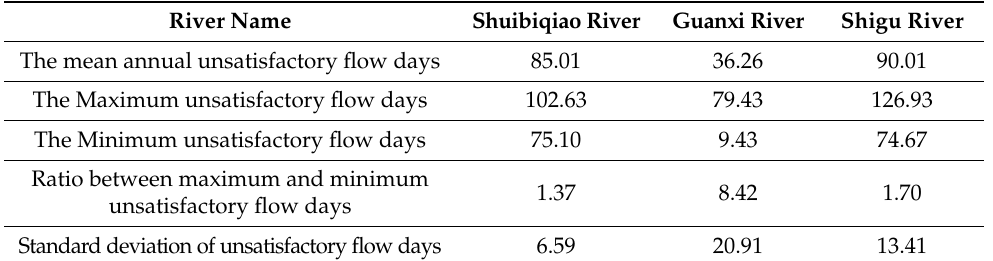
Table 4. The number of unsatisfactory days of ecological flow under different regulation scenarios.